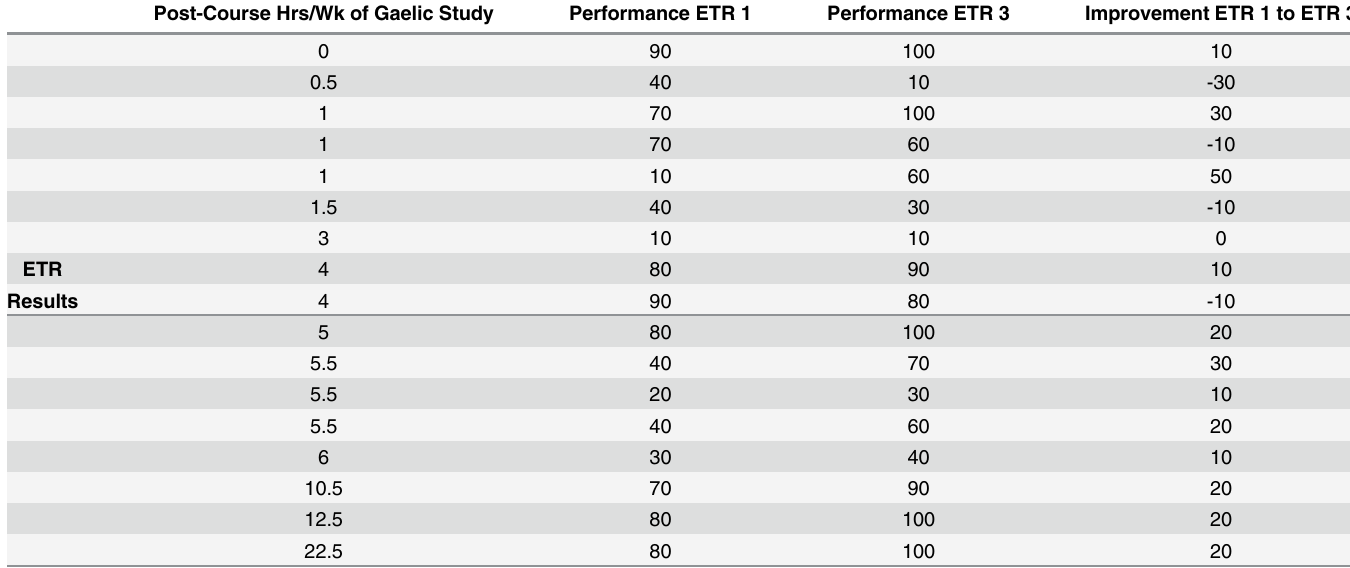
Table 3. Individual performance on the Elevator Task with Reversal pre-course and nine months later. Post-Course Hrs/Wk of Gaelic